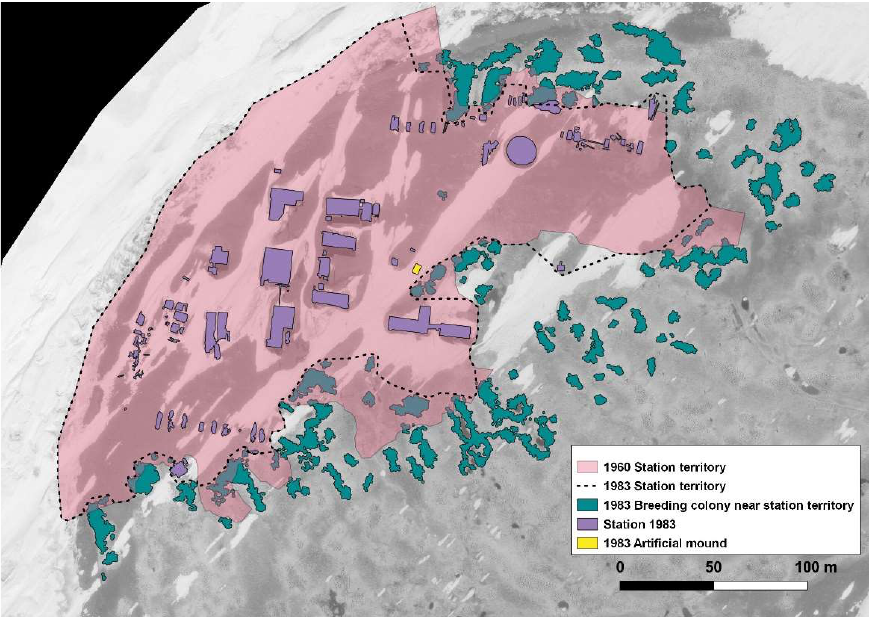
Figure 4. Cape Hallett station penguin colony status and the nearby station territory in 1983.